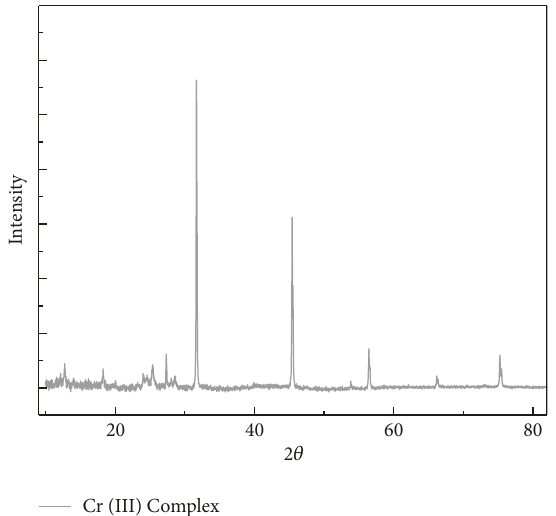
Figure 11: XRD pattern of Cr(III) compound.